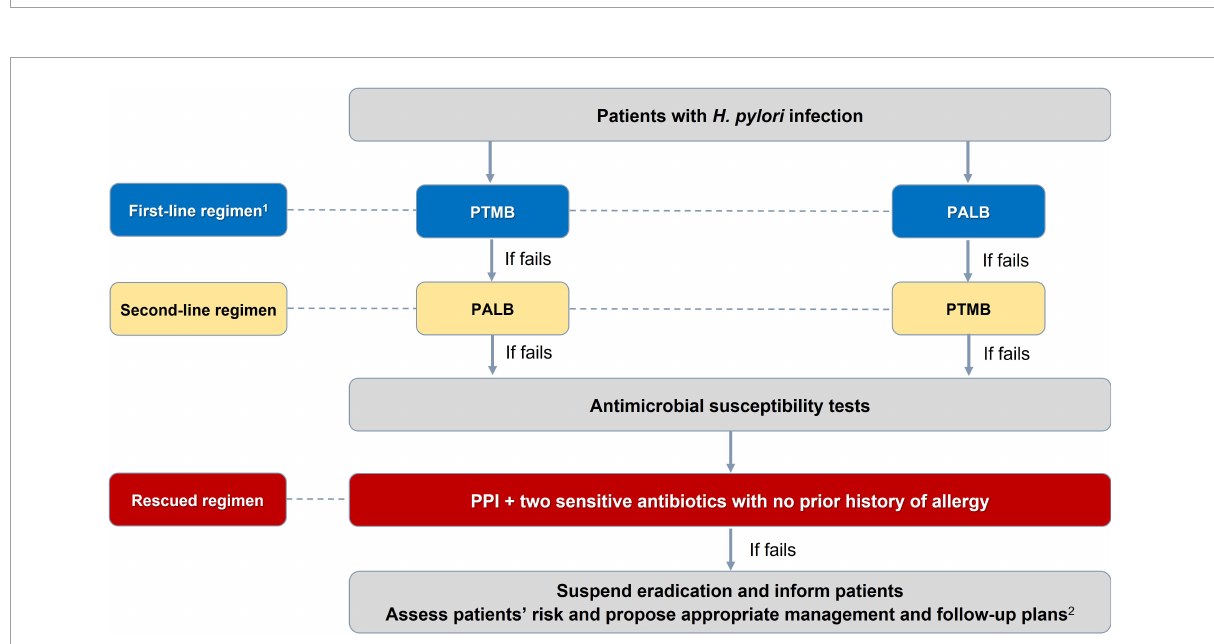
FIGURE2 Algorithm for selection of Helicobacter pylori eradication regimen. 1 PTMB is preferred over PALB because of its more stable and higher efficacy. PALB is also not used for people allergic to penicillin. 2 For patients with H. pylori -induced peptic ulcer diseases in whom H. pylori have not been successfully eradicated, maintenance anti-secretory therapy is needed. And those with gastric precancerous lesions need appropriate endoscopic follow-up plans to detect early gastric cancer. PTMB: PPI + Tetracycline + Metronidazole + Bismuth; PALB: PPI + Amoxicillin + Levofloxacine + Bismuth. All treatment regimens are in 14